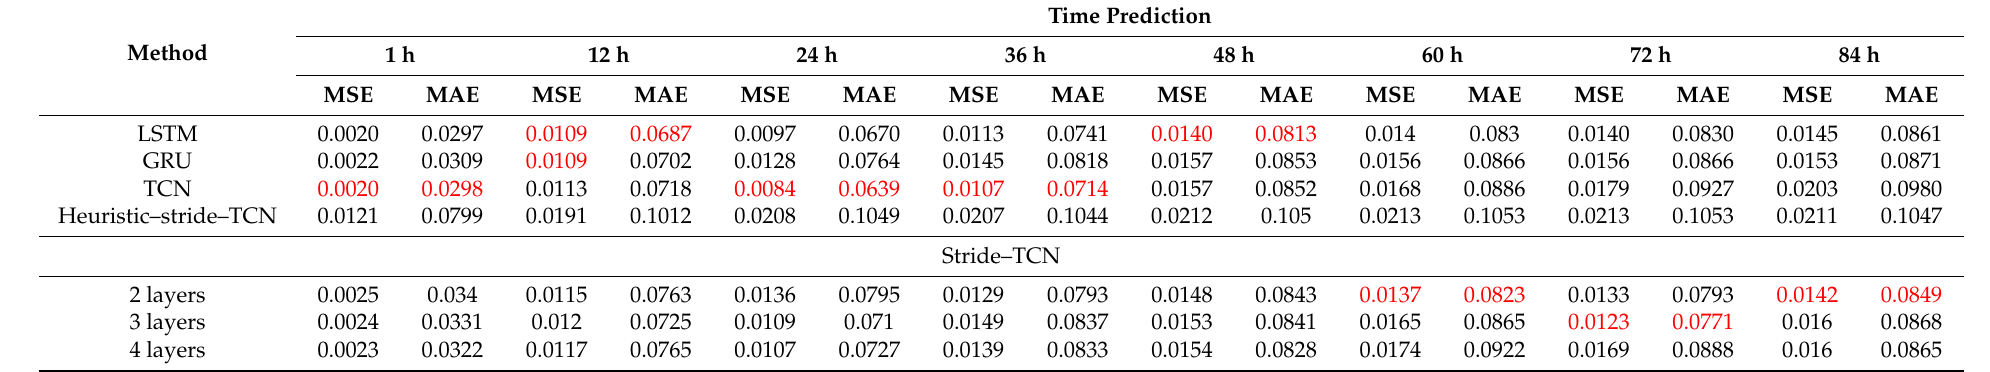
Table 5. Performance (MSE and MAE) of all models on the CNU dataset.